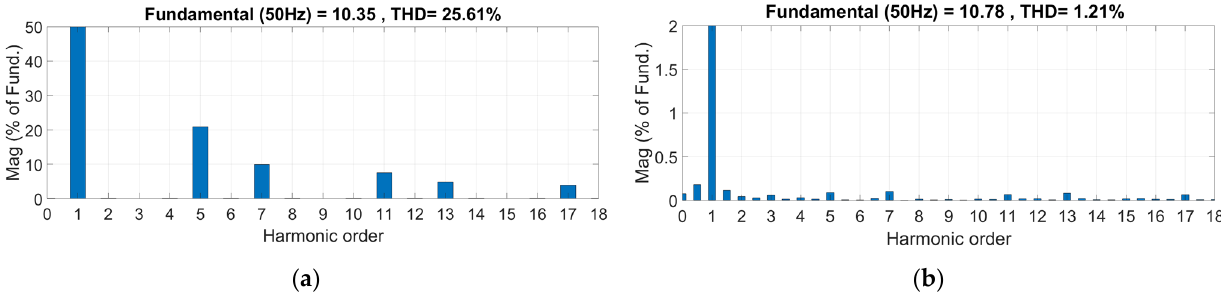
Figure 4. FFT analyzer for source current ( a ) without APF ( b ) with APF using PQ extraction.